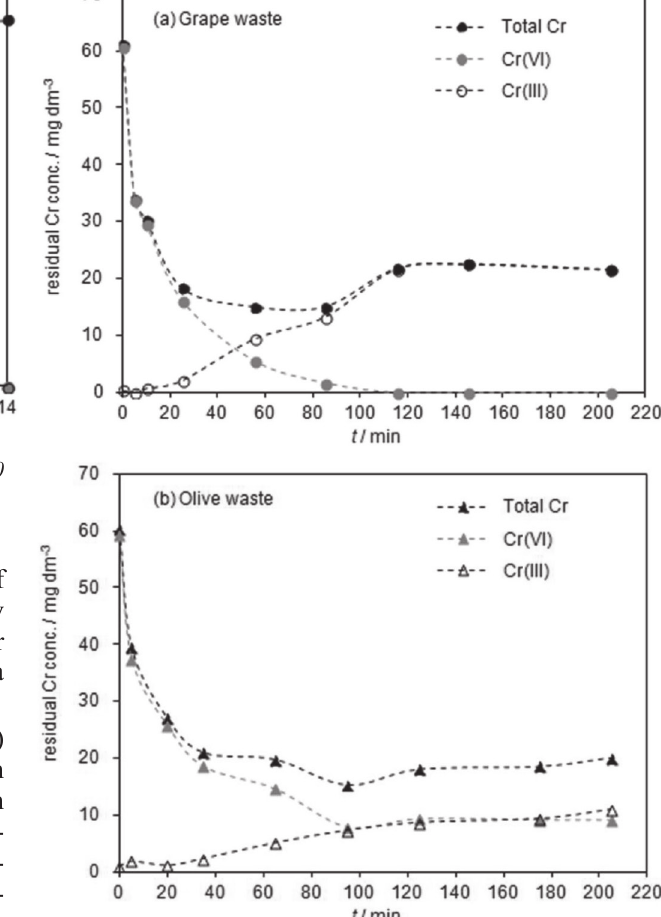
Fig. 4 – Concentration of total chromium, hexavalent and trivalent chromium in solution as a function of time after con- tact with grape waste (a) and olive waste (b) (γ V = 100 cm 3 , m = 0.5 g, pH = 2 and T = 20 0